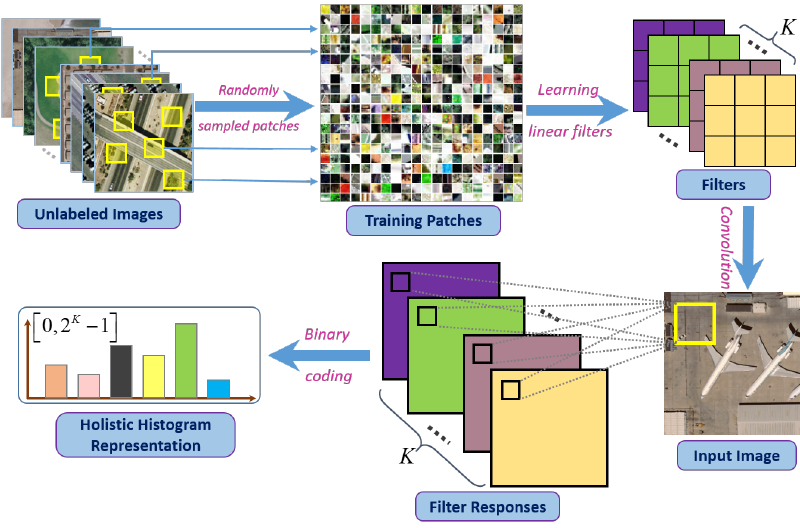
Figure 1. Pipeline illustration of the fast binary coding (FBC) for global feature representation of image scenes. The filters used in the FBC are preliminarily learned from a large amount of randomly-sampled image patches via a specific unsupervised method. We convolve each image scene with the learned filters to generate feature maps and then convert the binary-valued maps to an integer-valued map. Finally, we generate a histogram of features by counting the frequency of each integer.